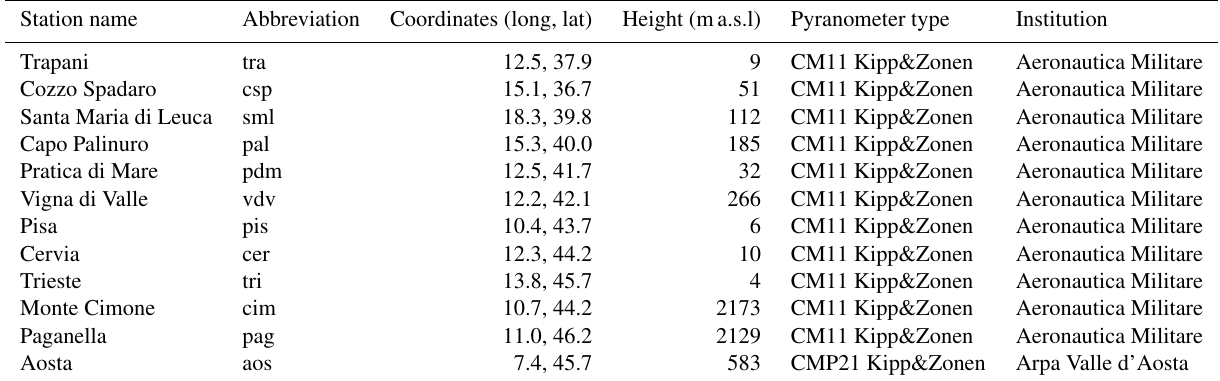
Table 2. Station names, abbreviations, coordinates, height above the sea level (metres, fourth column), instrument type, and managing institution for the 12